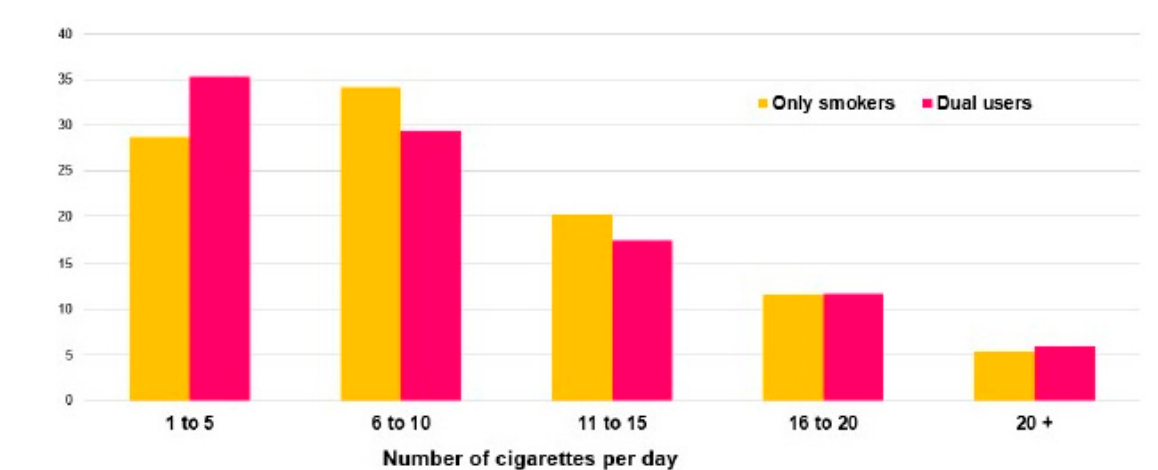
Figure 4. Level of daily combustible cigarette consumption in dual users (red bar) and those who only smoke combustible cigarettes (yellow bar) (number of cigarette/day).